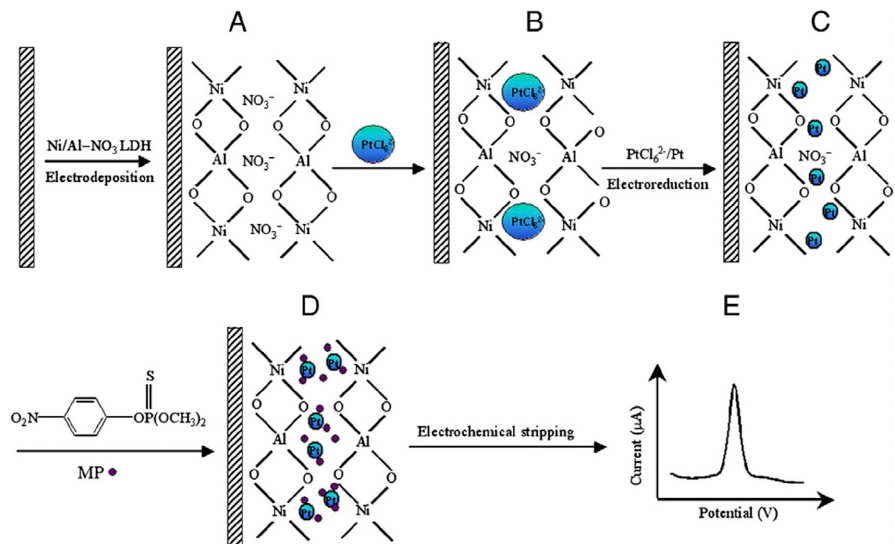
Figure 8. Schematic illustration for electrochemical sensing MP: ( A ) electrodeposition of a Ni/Al– NO 3 –LDH film onto a GCE surface; ( B ) subsequent exchange of PtCl 62 − with NO 3 − anions; ( C ) followed by electrochemical reduction to form the assembly of NanoPt-LDH onto GCE; ( D ) MP intercalated into the interlayer space of NanoPt-LDH/GCE; ( E ) electrochemical stripping detection of MP. Image reproduced from [69] with permission.